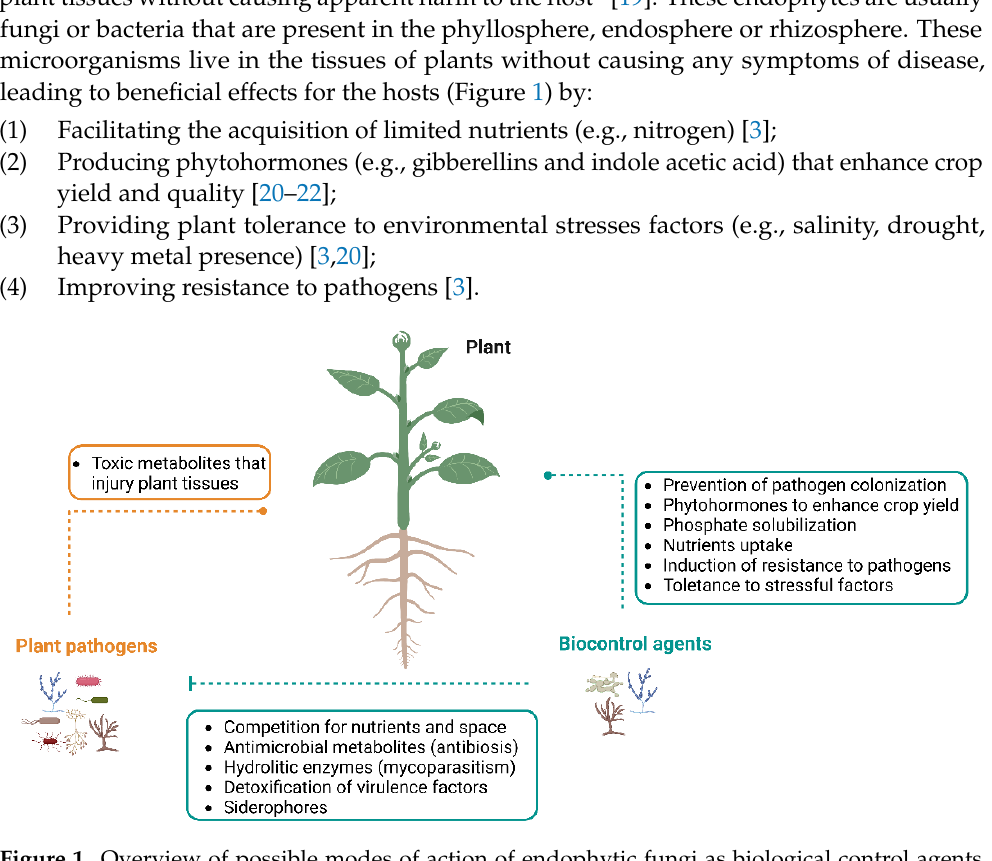
Figure 1. Overview of possible modes of action of endophytic fungi as biological control agents and plant-growth promoters. Beneficial microorganisms can exhibit direct antagonism against plant pathogens (inhibitor green line), as well as promote plant growth (dotted green line). Plant pathogens can also produce toxins to injure the plant (dot orange line). The figure was created with BioRender.com (accessed on 20 October 2022).